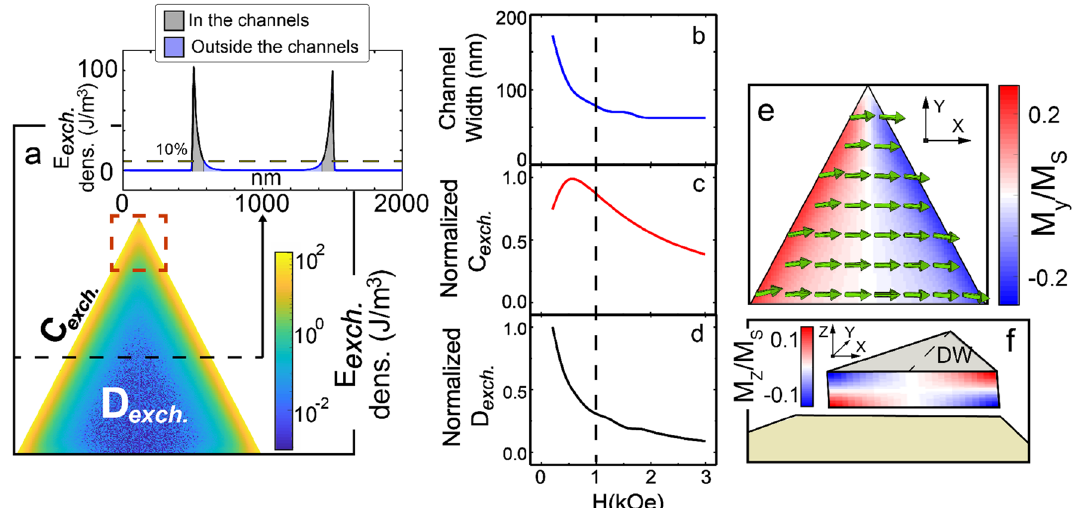
energy (D exch . ) against the applied field. Dashed lines in b , c and d indicate the optimal applied field (1 kOe) used in the dynamic sim- ulations. Parts e and f correspond to the zoomed area surrounded by the red dashed rectangle in a . e Illustrates the variation of the top corner static M y component magnetization profile in the bulk normalized by the saturation magnetization (M s ). Part f reveals an out-of-plane (OOP) profile, limited by the base of the dashed red rectangle in a , of the M z magnetization component normalized by M